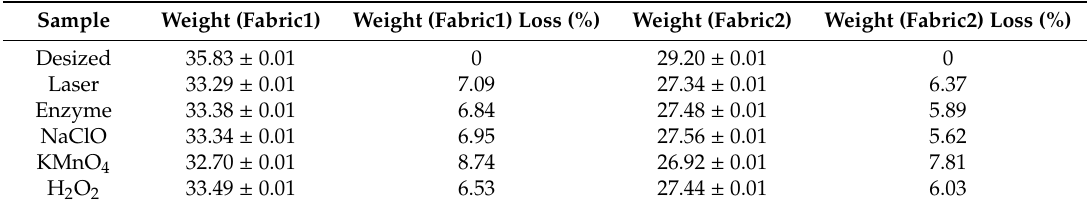
Table 5. Weight of denim fabrics with di ff erent bleaching types.